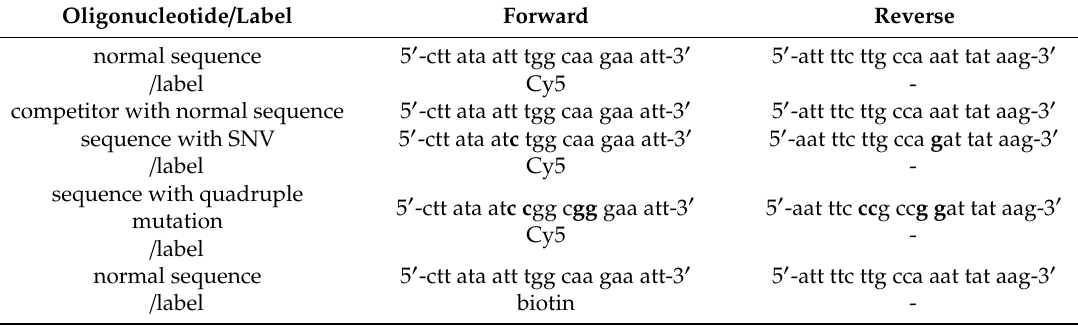
Table A1. Oligonucleotide sequences for protein identification, EMSA, DNA-a ffi nity purification and immunoprecipitation-based DNA-binding assay. Mutated positions / bases di ff ering from the GenBank-sequence are given in bold letters. Labels are at the 5 (cid:48)